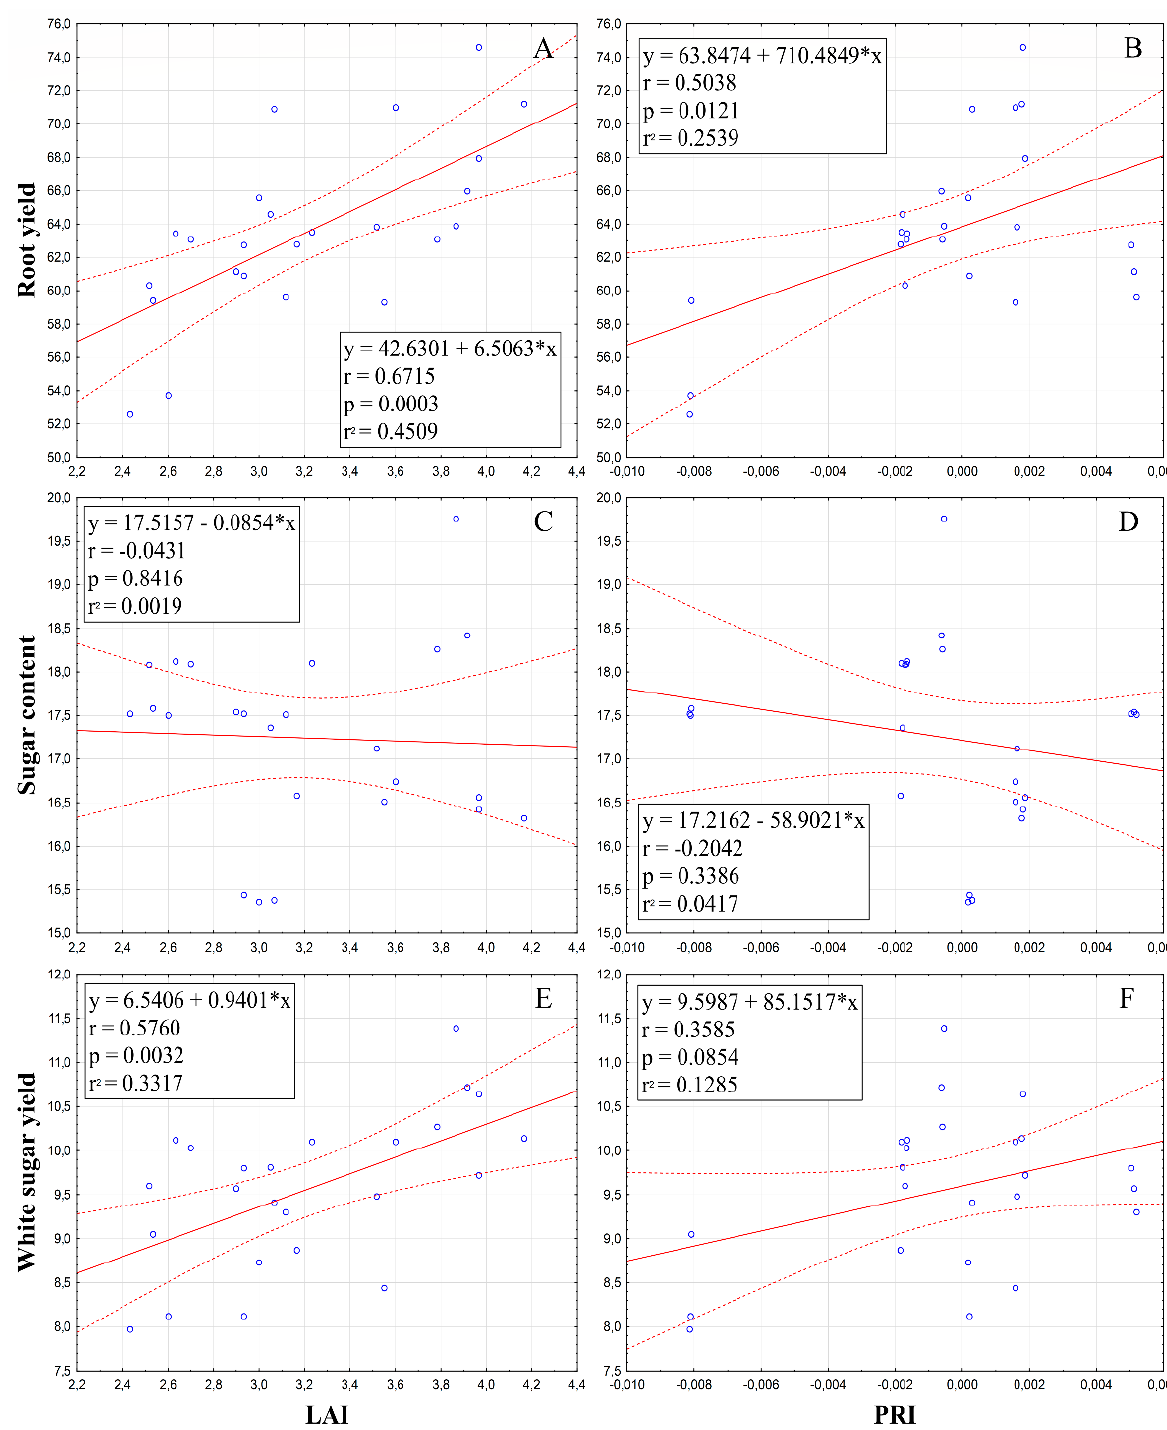
Figure 9. Relationships between leaf area index (LAI), resp. photochemical reflectance index (PRI) and production parameters: root yield ( A , B ); sugar content ( C , D ); white sugar yield ( E , F ). Linear equations, correlation coefficient, probability and regression are inserted inside graphs.